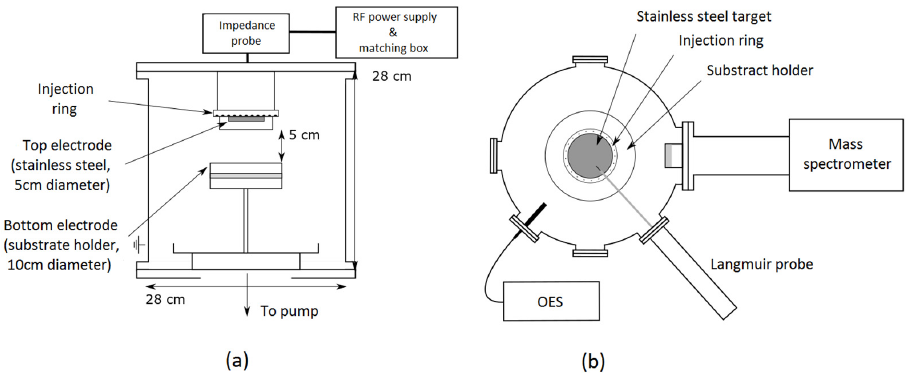
Figure 1. Overview of the experimental set up from ( a ) a side view and ( b ) a top view.